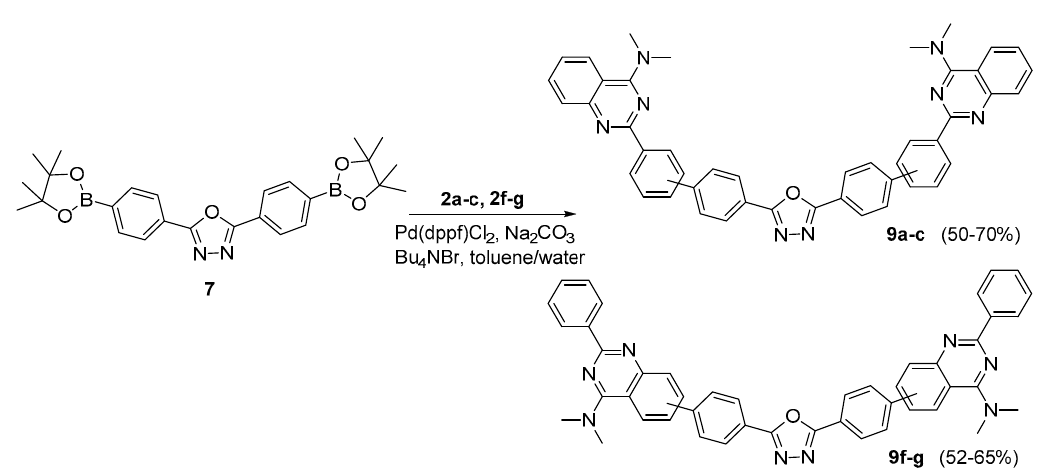
the dimethylamino group are observed in the range between 2.94–3.55 ppm.